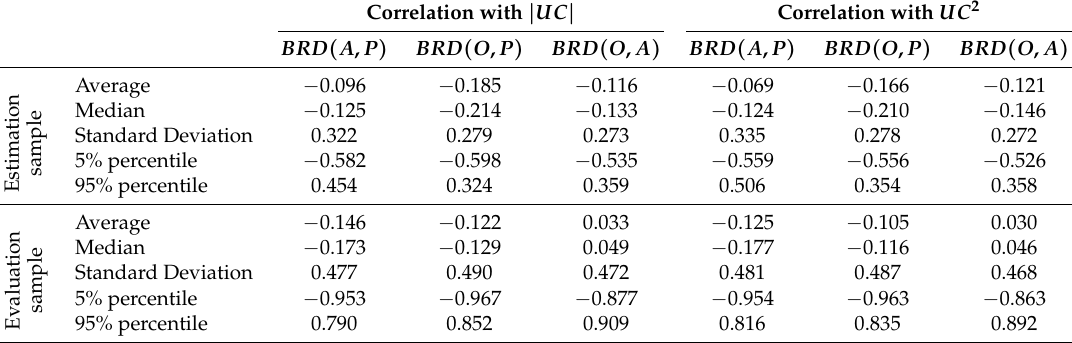
Table 13. A summary of results on the correlation between three balanced relative difference variables and two unpredictable component variables, calculated per individual forecaster. This is based on We calculated the correlation of the UC -variables with three balanced relative difference variables, − y with the definition BRD ( x , y ) = x with x and y being combinations of A (for the analyst forecast x + y error, FE 2 ), P (for the predictable component error, PCE 2 ) and O (for the optimal forecast error, OE 2 ). Correlation with | UC